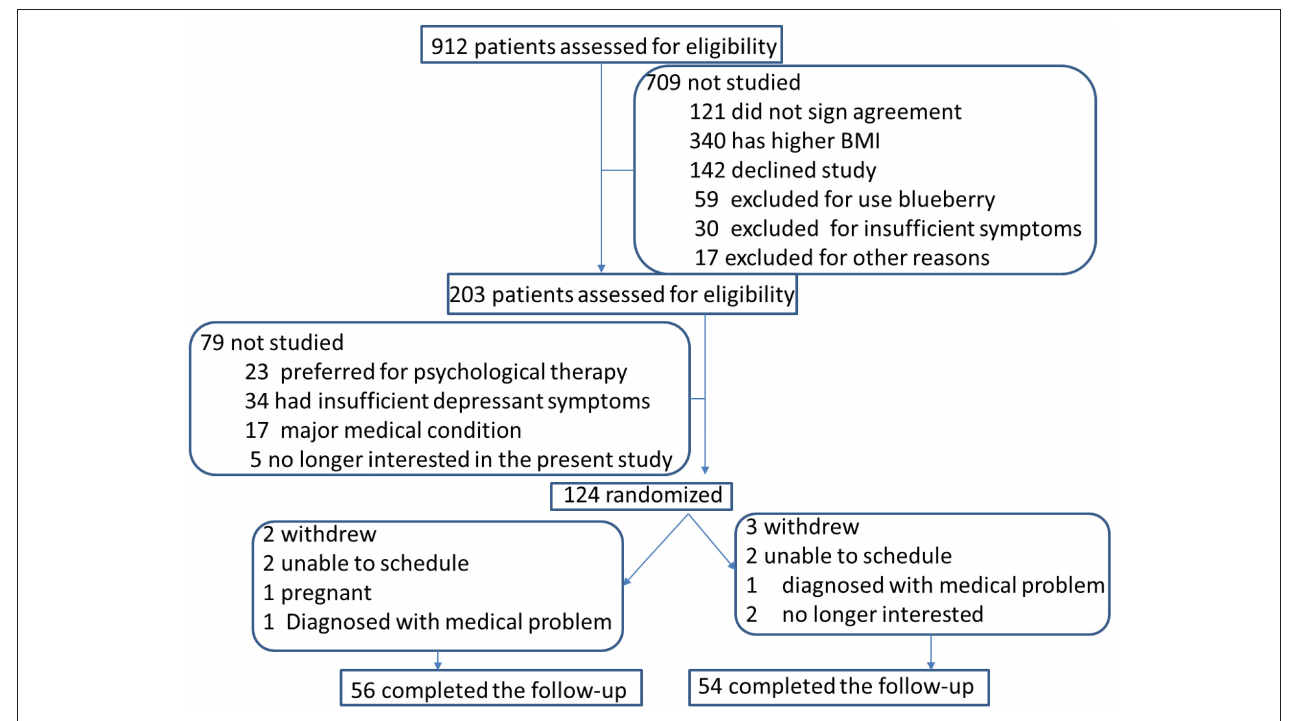
FIGURE 1 | The flowchart of the present study.